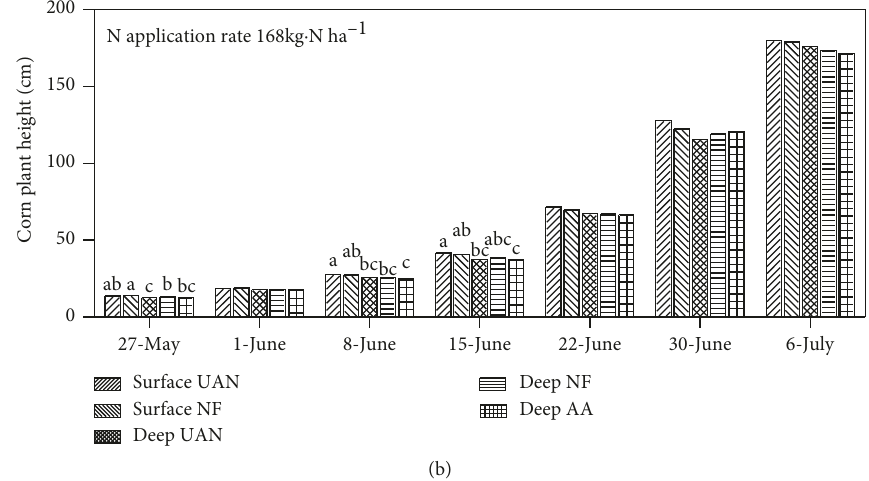
Figure 2: Corn plant heights due to N source placements averaged over N timing and years. Plant heights were measured on selected dates before VTat (a) 84 and (b) 168kg · N · ha − 1 . Letters over bars indicate differences among treatments within a given measurement date using Fisher’s Protected LSD ( P ≤ 0 . 05).